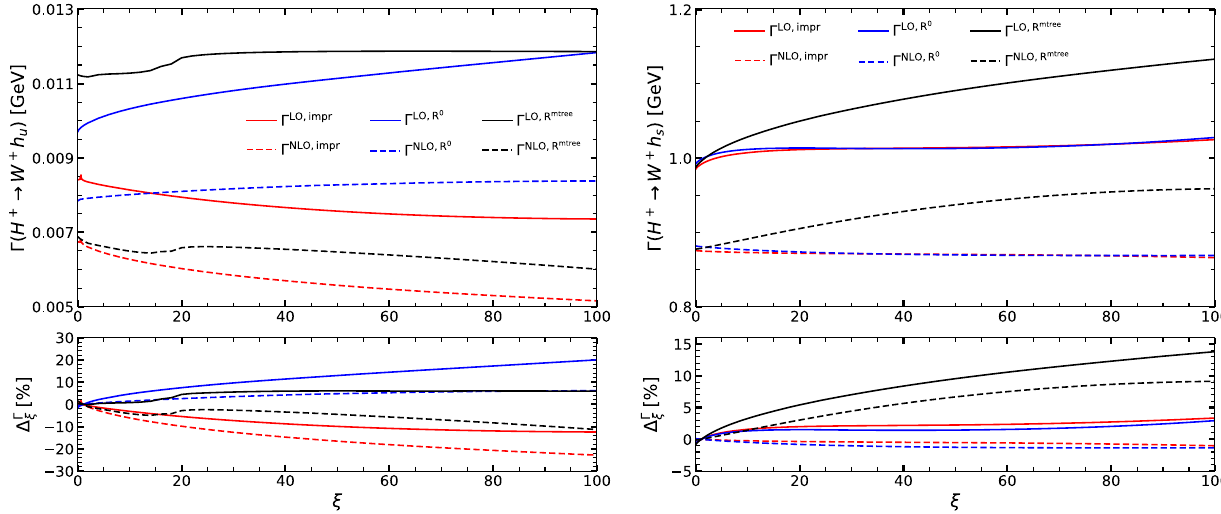
Fig. 14 Left:The h u -likeHiggsbosonmassesasafunctionof ξ attwo- loop O (α t α s + α 2 t ) levelintheOS(solidlines)andtheDR(dashedlines) scheme of the top/stop sector for scenario P2, i.e. λ = 0 . 33 ,κ = 0 . 41 (red line), for half their values (blue) and for λ/ 100, κ/ 100 (black).